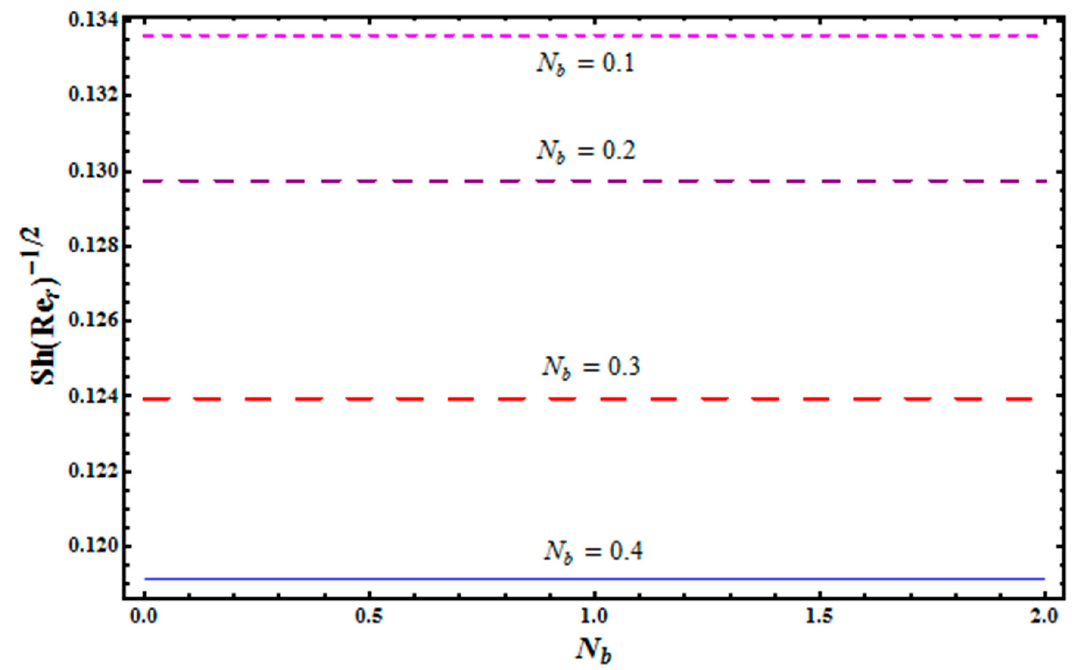
Figure 19. Curves of Sh ( Re r ) − 1/2 for N b . Table 1. Comparative values of f (cid:48)(cid:48) ( 0 ) and g (cid:48) ( 0 ) for value of Fr when λ = 0.2. Present